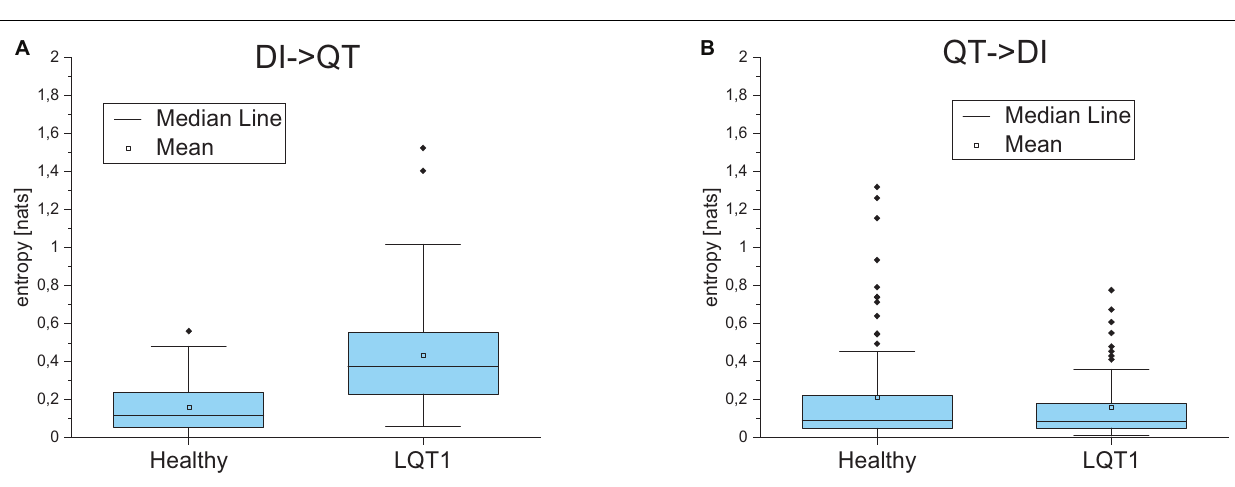
individuals, most often with TE less than 0.05 ( Figures 5A, 5B